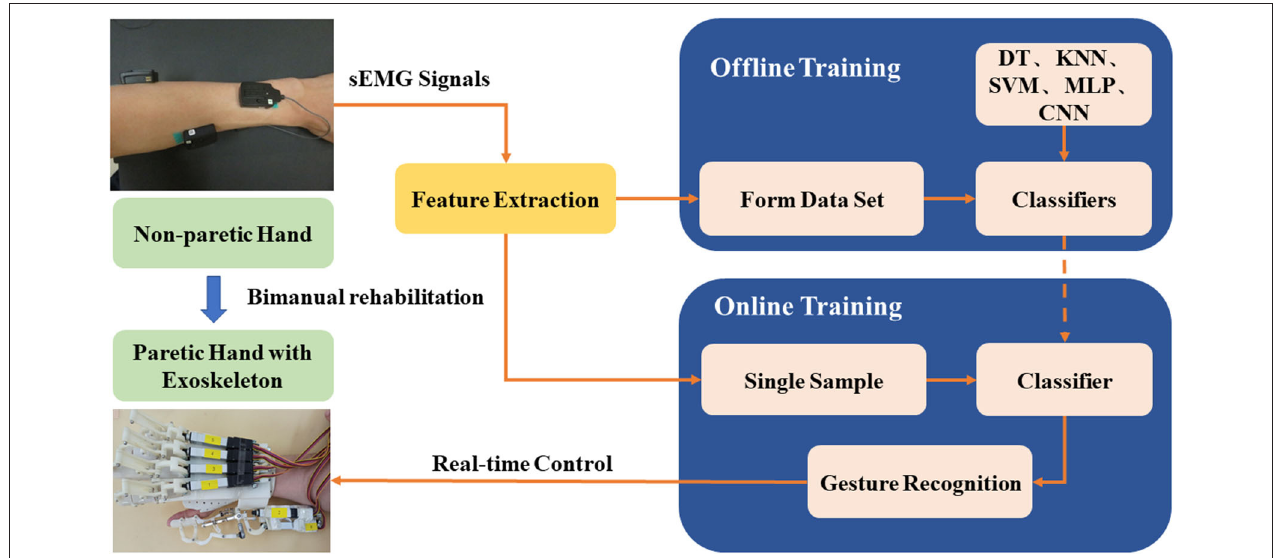
FIGURE 2 | Schema of the control system for the hand exoskeleton based on non-paretic sEMG processing and offline-to-online classifications.